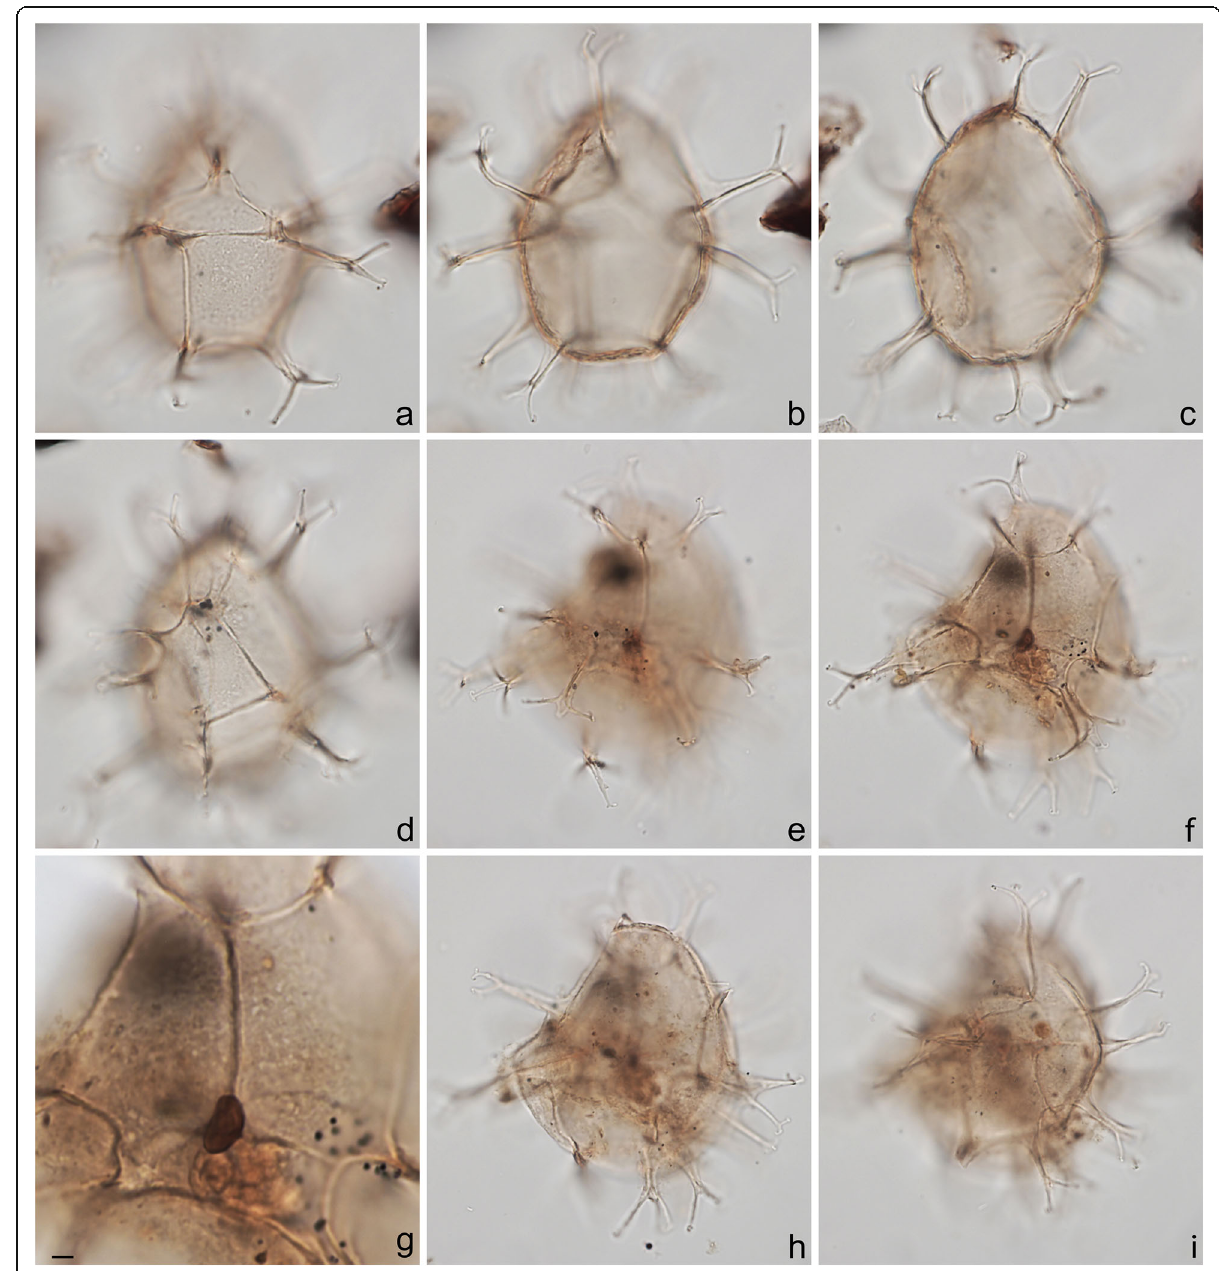
Fig 6 Dinoflagellate cysts from the Chiba composite section. Max. dia. = maximum diameter. EF = England Finder reference. a – i Spiniferites pachydermus sensu Mertens et al. (2015) showing distinctive irregularly perforate surface ornament; a – d left lateral view at upper to lower foci; central body length 49 μ m; sample TB2 00, slide 1 (10 μ m), EF D11/2; e – i right lateral view at upper through lower foci; note irregular